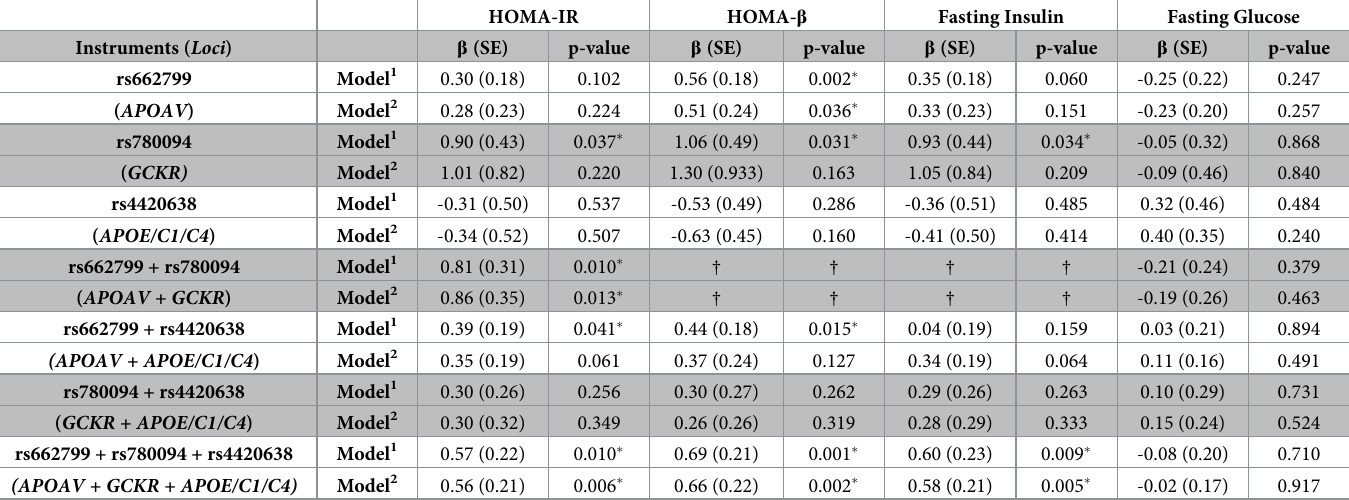
Table 4. MR sensitivity analyses for different combination of triglyceride SNPs with glycemic